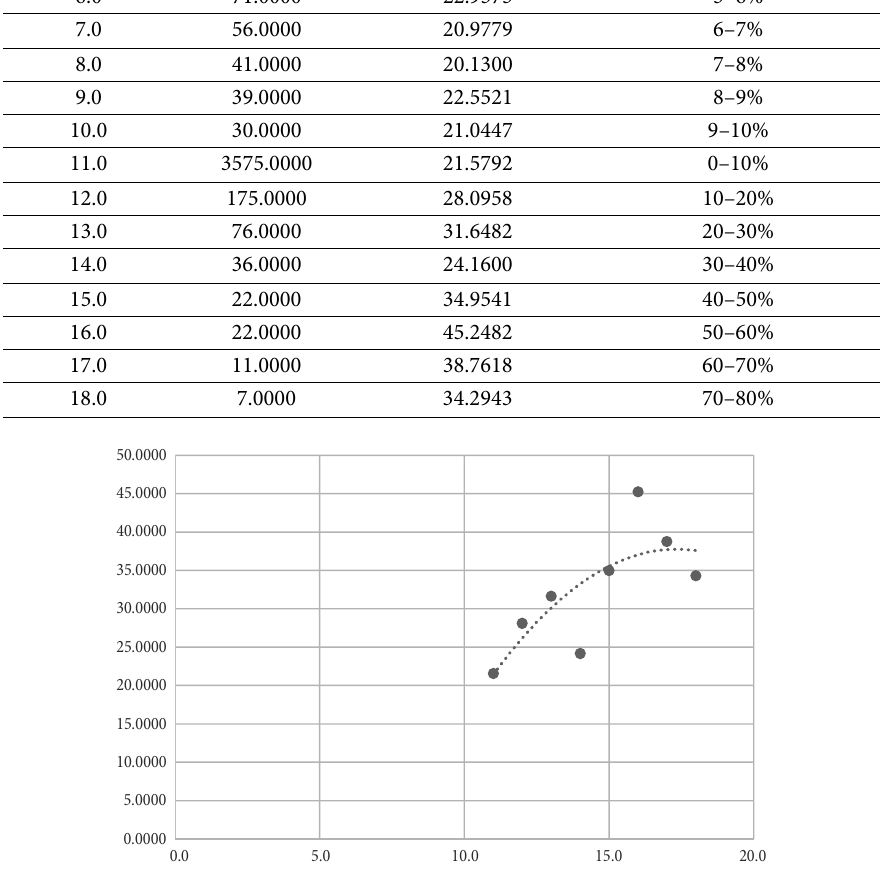
Fig. 2A. Graphical representation of mean gross margin by intangible assets intervals (polynomial